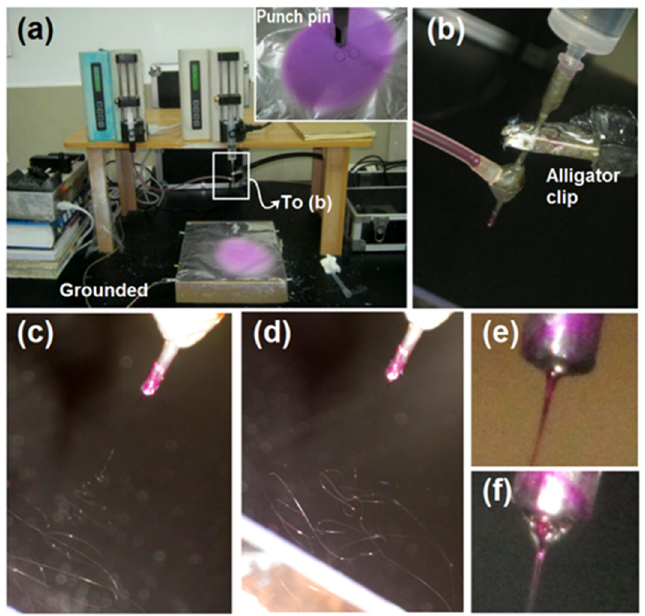
Figure 2. Digital photos exhibiting the preparation processes: ( a ) a whole image of the electrospinning apparatus, the upper-right inset showing the collected nanofibers films prepared by the single-fluid blending process of the core fluid; ( b ) the connection of the spinneret with the two working fluids and the power supply; ( c ) a typical process for creating HPMC-based nanocomposites solely from the core fluid; ( d ) a typical process for producing the core–shell hybrids from the modified coaxial processes; ( e , f ) Taylor cones for preparing monolithic composites and core–shell nanohybrids,